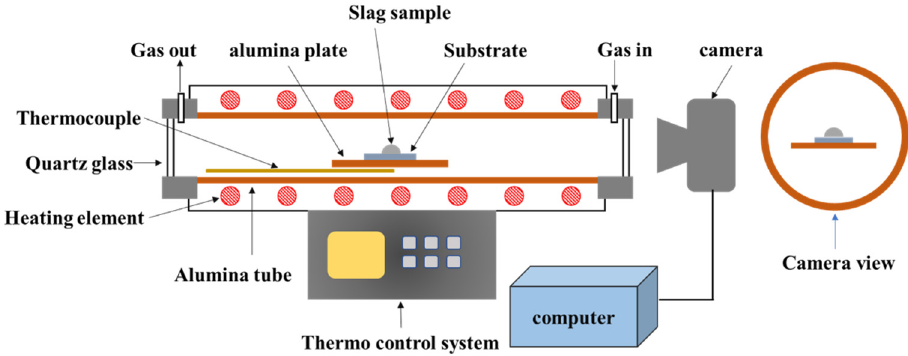
Figure 2. Schematic representation of the setup used for high-temperature optical image.